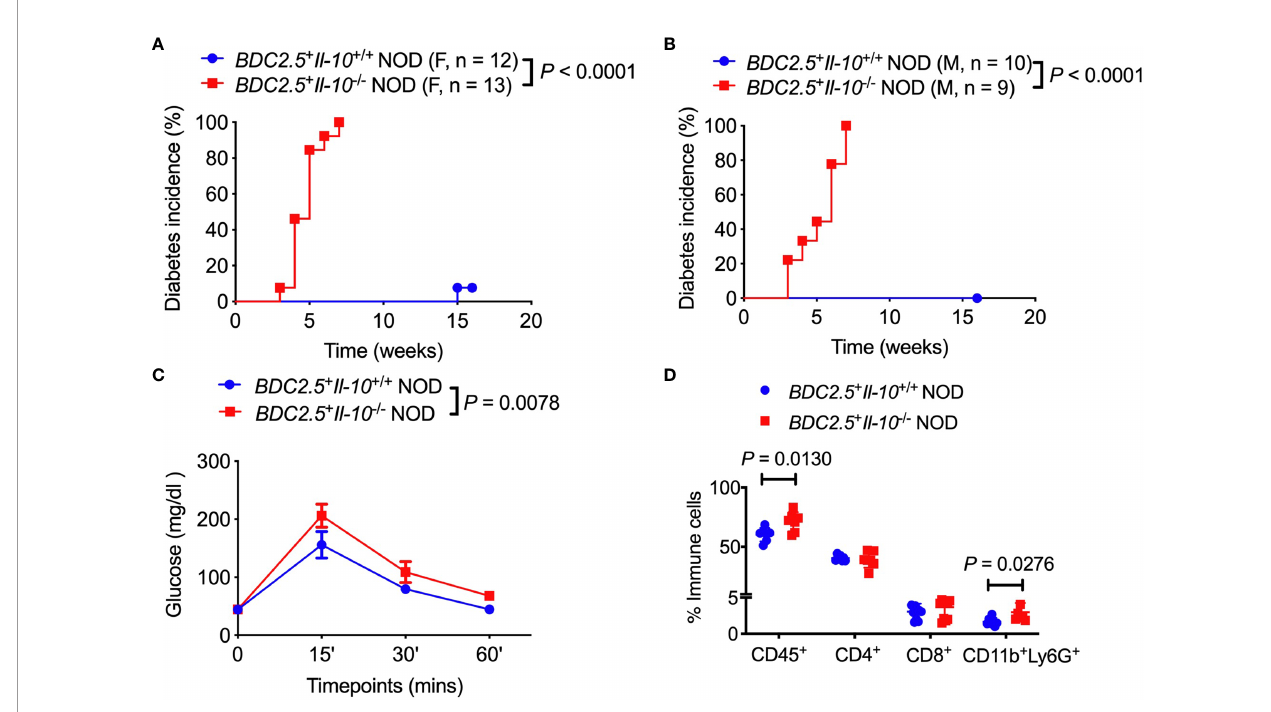
FIGURE 1 | Il-10 de fi ciency in BDC2.5 + NOD mice induced rapid development of type 1 diabetes. (A, B) Natural history of type 1 diabetes development in BDC2.5 + Il-10 +/+ NOD mice and BDC2.5 + Il-10 -/- NOD littermates from females [ (A) , n = 12-13/group] and males [ (B) , n = 9-10/group]. (C) Intraperitoneal glucose tolerance test (IPGTT) in BDC2.5 + Il-10 +/+ NOD mice and BDC2.5 + Il-10 -/- NOD mice (n = 5/group). (D) In fi ltrated immune cells in the islets of mice ( n = 7-11/group). In fl ow cytometric analysis, CD45 + immune cells were gated from live cells. CD4 + T cells, CD8 + T cells, CD11b + Ly6G + neutrophils were gated from CD45 + immune cells. Data in (A, B, D) were pooled from two or more independent experiments. The experiment in (C) was performed twice, and consistent results were obtained. Data were analyzed using a log-rank test for survival (A, B) , a two-way ANOVA (C) , or a two-tailed Student ’ s t -test [ (D) , Data are presented as mean ± SD]. P < 0.05 was considered statistically signi fi